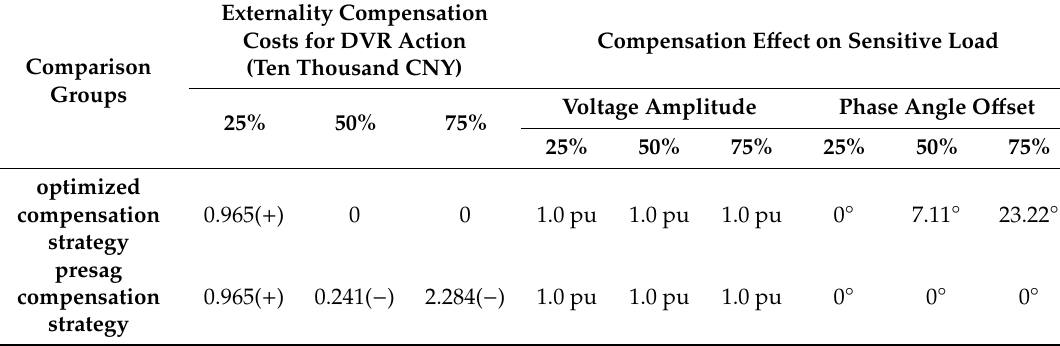
Table 6. Comparison of optimized compensation strategy and presag compensation strategy when phase angle jump compensation is not